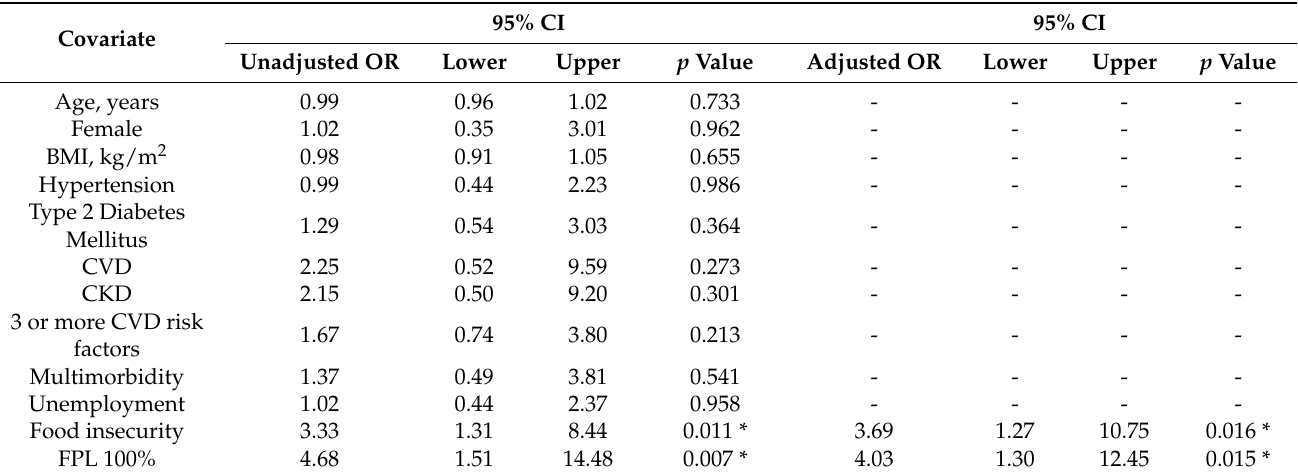
Table 2. Univariate and Multivariate Logistic Regression for Low TSH (<2 mIU/L) †.